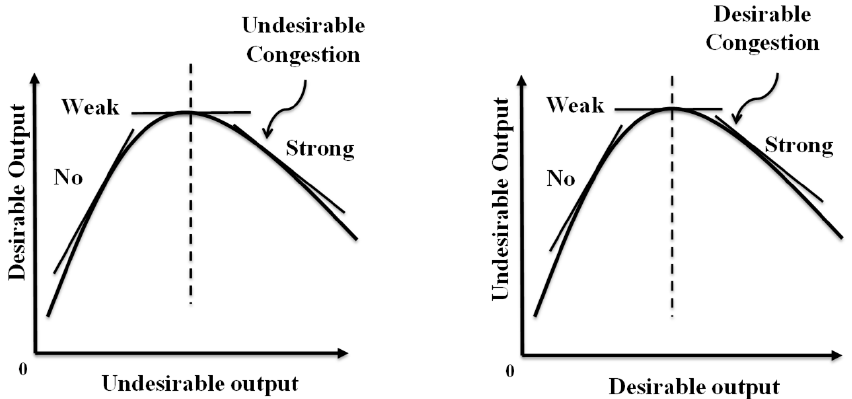
Figure 2. Undesirable congestion (UC) and desirable congestion (DC). (a) The left hand side indicates an occurrence of UC while the right hand side indicates that of DC. The UC implies a production capacity limit on g . The DC implies eco-technology innovation on b